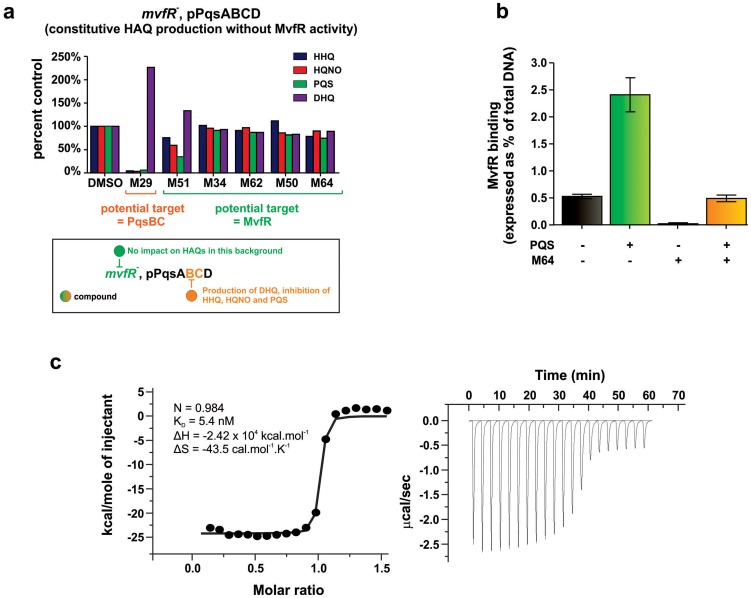
Identification of the molecular target and mode of action of the MvfR-regulon inhibitors.
a. The potential molecular target of an inhibitor is revealed by the pattern of HAQ and DHQ production in response to 100 µM of the inhibitor in mvfR mutant cells that constitutively express pqsABCD. Compounds that target MvfR should not impact HAQs production (e.g., M51, M34, M62, M50, M64); compounds that inhibit the PqsB or PqsC enzymes should result in increased DHQ, which is produced by PqsA/D, and reduced levels of HHQ, PQS, and HQNO, which require the PqsABCD enzymes (e.g., M29). b. 0.24 µM M64 blocks MvfR binding to the pqsA promoter of PA14, minus and plus 38 µM PQS. Binding was assessed by ChIP-qPCR and normalized to the rpoD promoter that lacks an MvfR binding site. MvfR bound DNA was expressed as the percent of total input DNA. Error bars represent mean +/− SEM of at least 3 replicates. c. Isothermal titration calorimetry analysis of the interaction between MvfRc91 (19 µM) and M64 (200 µM). Heat signals of the M64 titration into MvfRc91 are plotted against the molecular ratio between M64 and MvfRc91 (left panel), and against time (right panel). The best-fit curve corresponds to a single-site binding model. The stoichiometry of binding (N), association constant (KA), enthalpy (ΔH), and entropy of binding (ΔS) are presented.